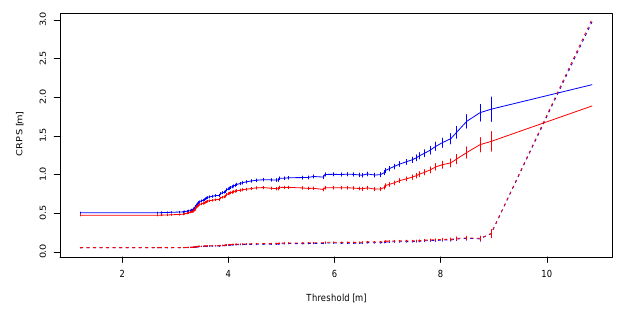
Figure 5. Summary plot of the CRPS results of two model fits. The lines correspond to the mean CRPS value evaluated based on the time steps for which the observed value exceeded the threshold shown on the x axis. Where shown, the vertical error bars repre- sent ± 2 standard deviations of the mean estimate. The results of two pathway models with a 5h time delay and with (red) or without (blue) the power law non-linearity are shown for both the estimated model (solid) and for the 5h lead time forecasts (dashed).